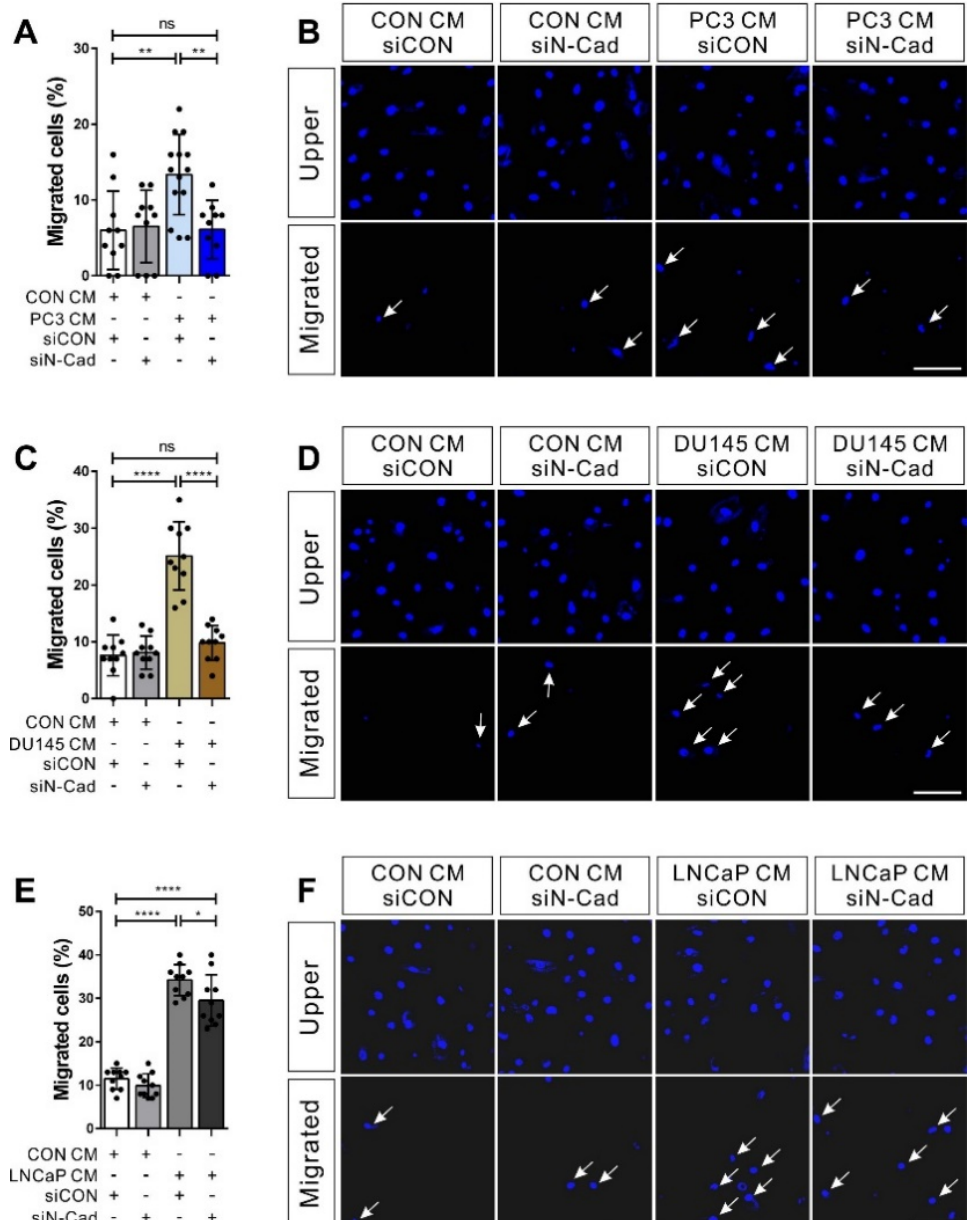
Figure 5. N-cadherin mediates the migration of bone marrow-derived mesenchymal stem cells (BM-MSCs) toward hormone- insensitive prostate tumor cell-conditioned medium. Migration of BM-MSCs transfected with each siRNA in response to prostate tumor cell-conditioned medium. BM-MSCs transfected with control siRNA (siCON) or N-cadherin siRNA (siN-Cad) treated with the PC3-conditioned medium (PC3 CM; ( A , B )), the DU145-conditioned medium (DU145 CM; ( C , D )), the LNCaP-conditioned medium (LNCaP CM; ( E , F )), or the control-conditioned medium (CON CM) for 12 h. White arrows indicate DAPI-stained nuclei of migrated BM-MSCs on the lower membrane surface. Results are presented as the mean ± SD ( n = 2 samples for each group; two independent experiments). Scale bars indicate 100 µ m. The statistical significance was determined by the p -value obtained by t -test (* p ≤ 0.05; ** p ≤ 0.01; **** p ≤ 0.0001; ns, p >